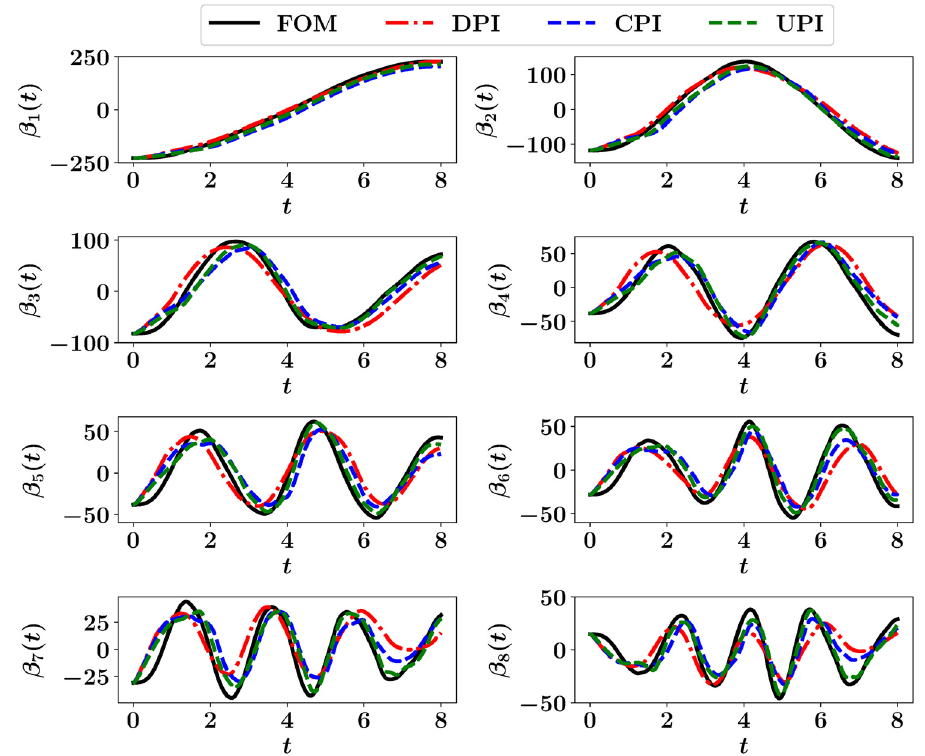
Fig 7. Projection of the predicted temperature fields at different times from FOM, DPI, CPI and UPI onto the POD basis function.